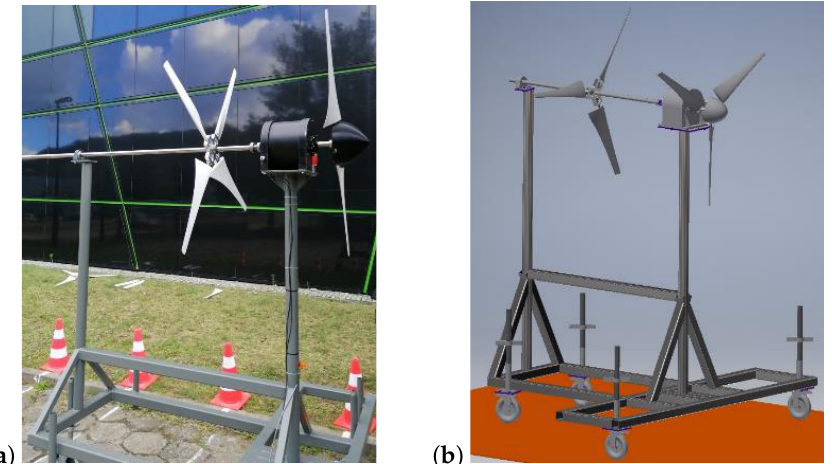
Figure 16. Permanent-magnet dual-rotor generator coupled with counter-rotating wind turbine for efficiency wind research: real photo ( a ), virtual model ( b